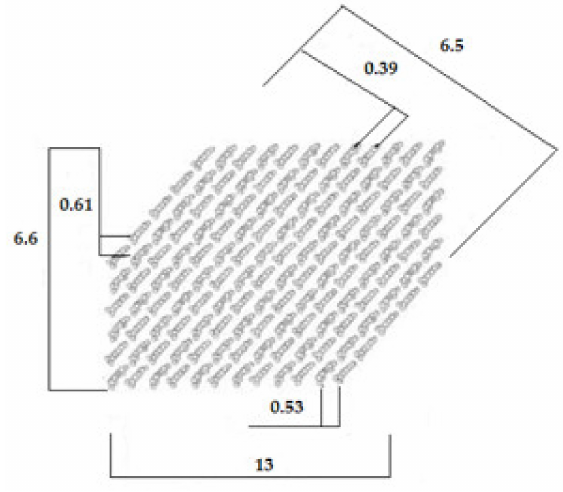
Figure 9. Suggested cross-section of the BTR BNC crystallites. The dimensions, given in nm, were calculated from the width of the X-ray diffraction peaks using Scherrer’s equation (Table